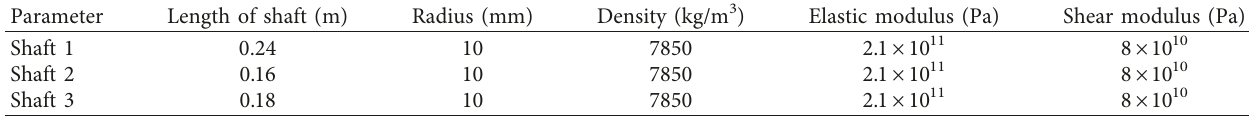
Table 1: Parameters of the transmission shaft.